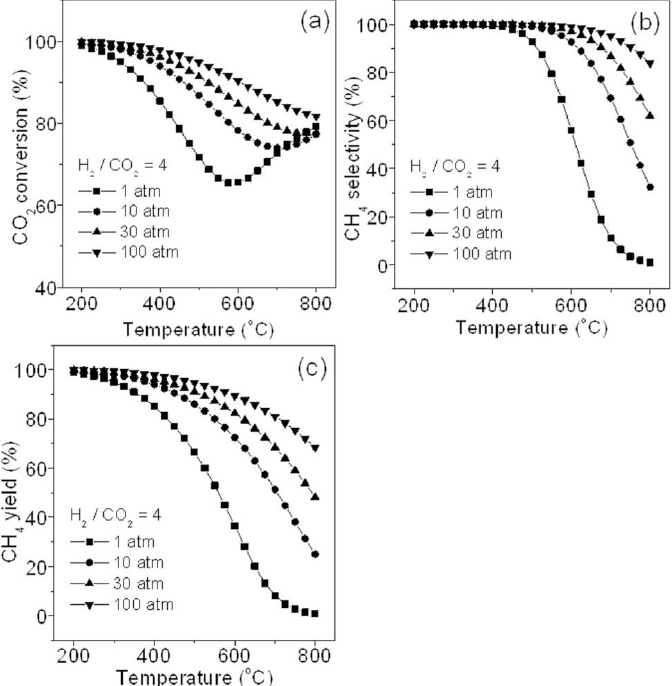
Figure 3. Effects of pressure and temperature on CO 2 methanation: ( a ) CO 2 conversion, ( b ) CH 4 selectivity, and ( c ) CH 4 yield. Reprinted from [18].